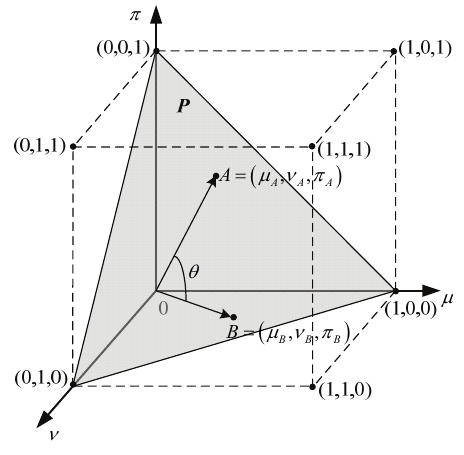
Fig. 2. The conception of an improved cosine similarity measure